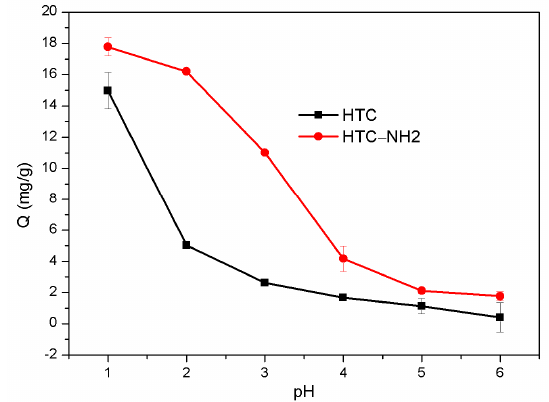
Figure 5. Effect of initial pH on Cr(VI) adsorption.